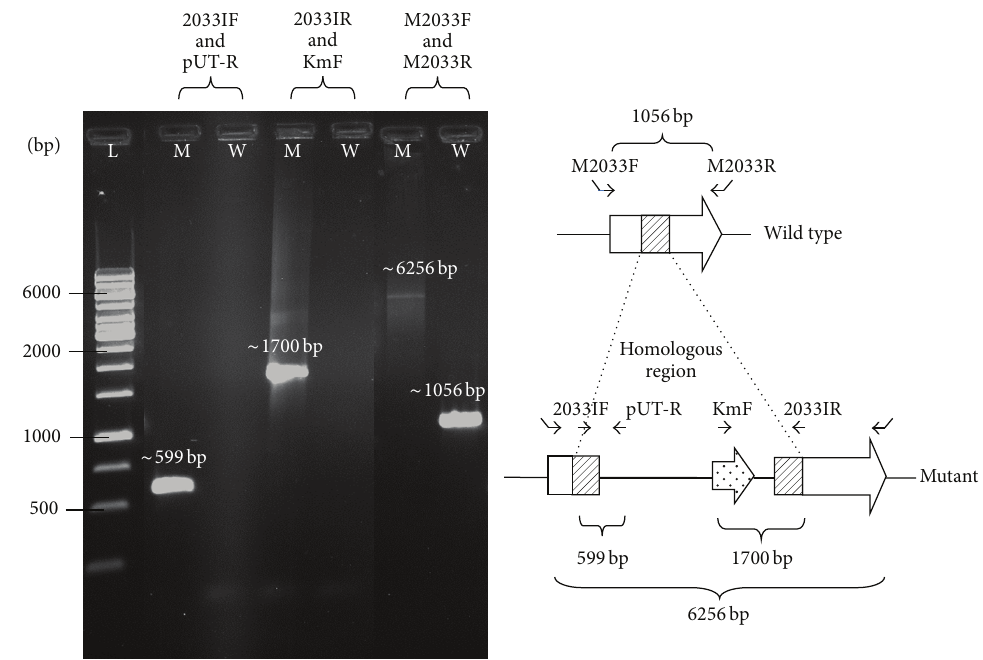
Figure 1: Representative of mutant construct. Verification of the construction of BPSL2033::Km mutant by PCR using specific alignment primers. M and W represent mutant and wild-type strains, respectively, while L indicates 1kb DNA ladder from Fermentas (USA).